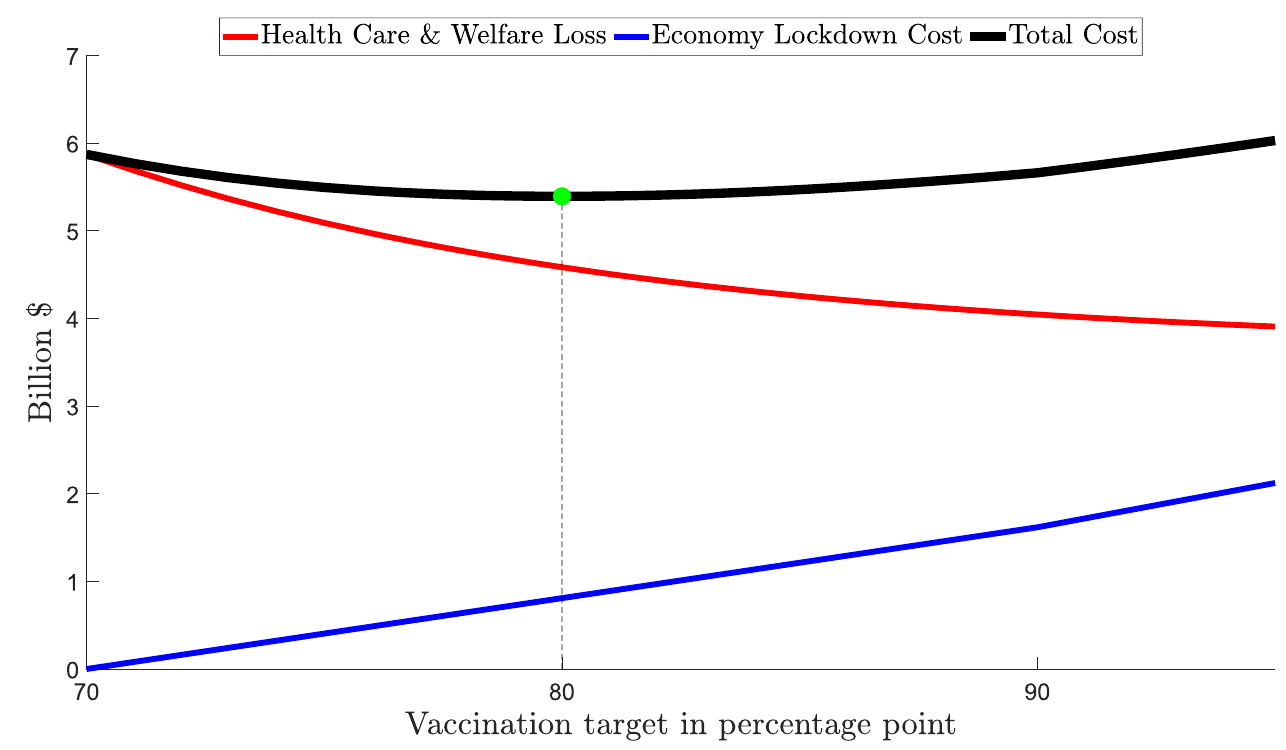
Fig 3. NSW: Societal costs of different lockdown ‘opening up’ vaccination rates. Notes about Fig 3: 1. All costs are counted from October 11 th 2021. 2. Total costs = health care costs and welfare losses + economy lockdown costs.